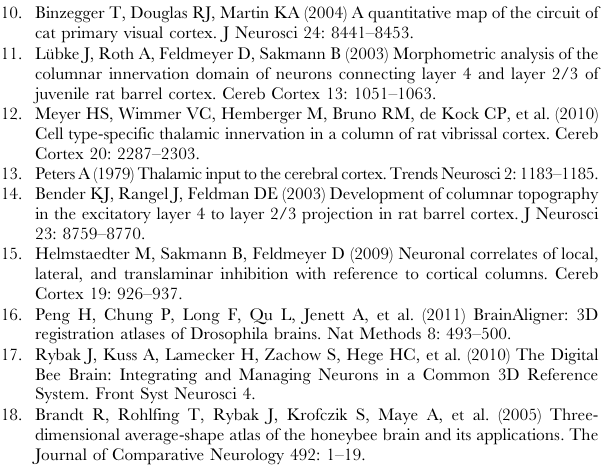
Figure S1 Automated segmentation of anatomical land- mark contours from 4 6 images (see also Figure 1E).